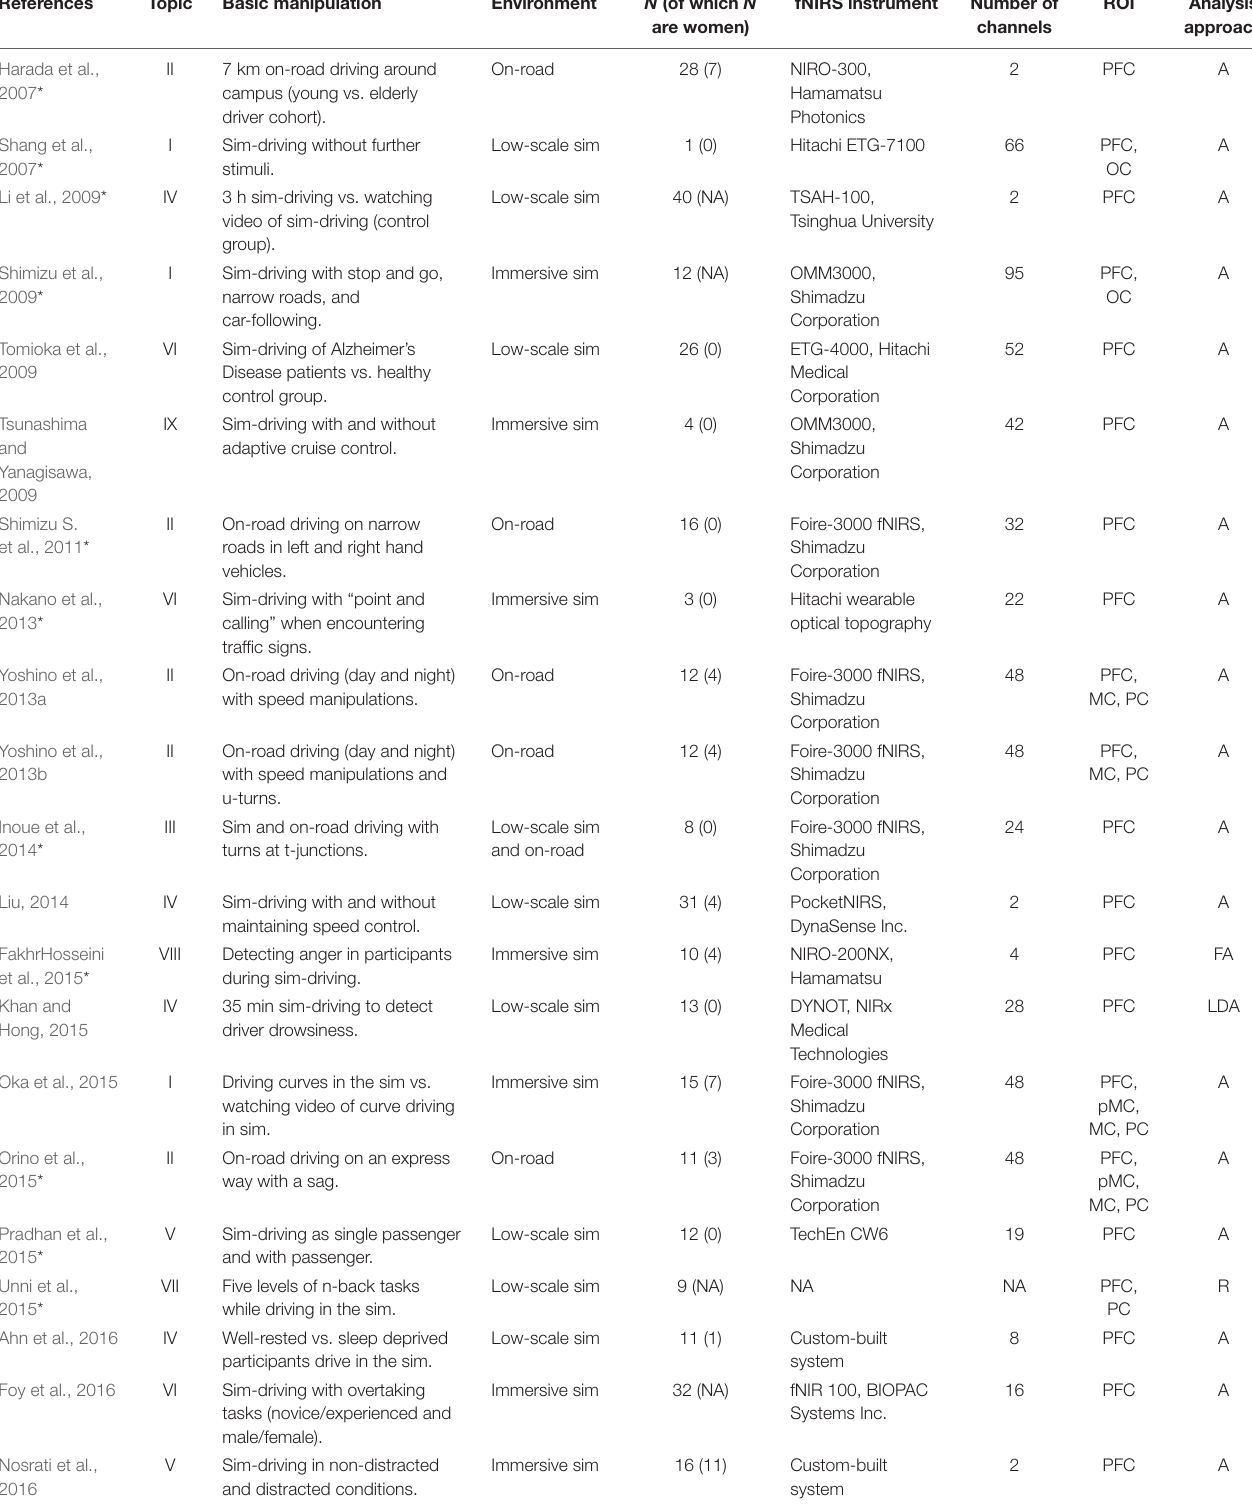
TABLE 1 | Overview of driving research utilizing